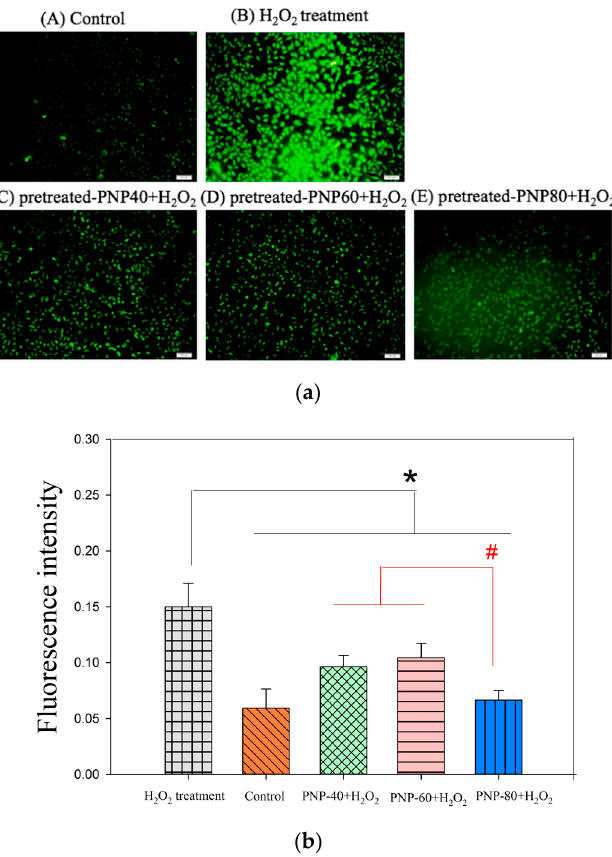
Figure 4. ( a ) Radical scavenging activity of PNPs (500 µg/mL) on L929 cells against H 2 O 2 -induced ROS generation (scale bar = 100 µm). Control (A), H 2 O 2 -induced L929 cells without PNPs pre-treatment (B), with PNP-40 pre-treatment (C), with PNP-60 pre-treatment (D), and with PNP-80 pre-treatment (E). ( b ) Quantitative analysis of the radical scavenging effect of PNPs-pretreated on L929 cells against H 2 O 2 -induced ROS generation. The experiments were conducted in triplicate independently ( n = 3), and the data are expressed as the means ± standard error (SE) (* p < 0.05 compared with H 2 O 2 -treated L929 cells without PNPs; # p < 0.05 compared with PNPs-pretreated against H 2 O 2 -induced L929 cells).